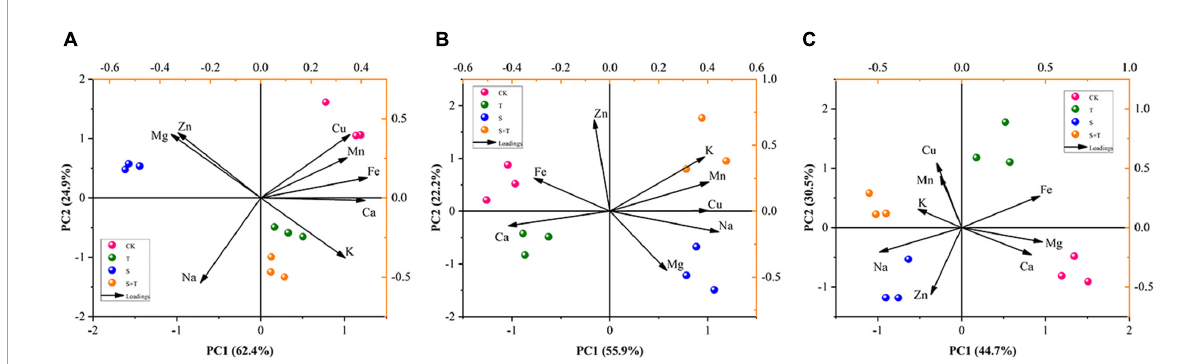
FIGURE9 Principal component analysis (PCA) of tissue ionome variation in tomato under salt stress by Tre treatment, with the loadings of mineral elements to the PC1 and PC2. (A) Root ionome variation among treatments and the loadings of elements to the PC1 and PC2. (B) Stem ionome variation among treatments and the loadings of elements to the PC1 and PC2. (C) Leaf ionome variation among treatments and the loadings of elements to the PC1 and PC2. CK, control; T, 10 mM Tre; S, 150 mM NaCl; S+T, 150 mM NaCl + 10 mM